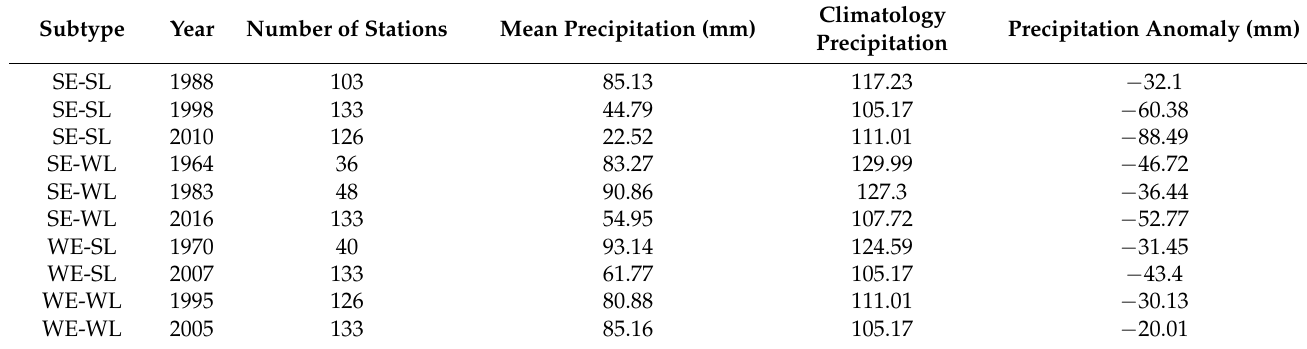
Table 2. Autumn precipitation values for all cases of ENSO transition type 1 years, averaged across the available meteoro- logical stations for each year.